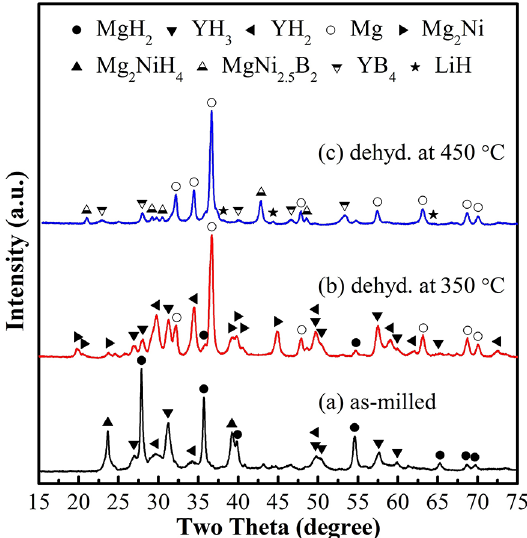
/Mg YNi-H composite as- 4 10